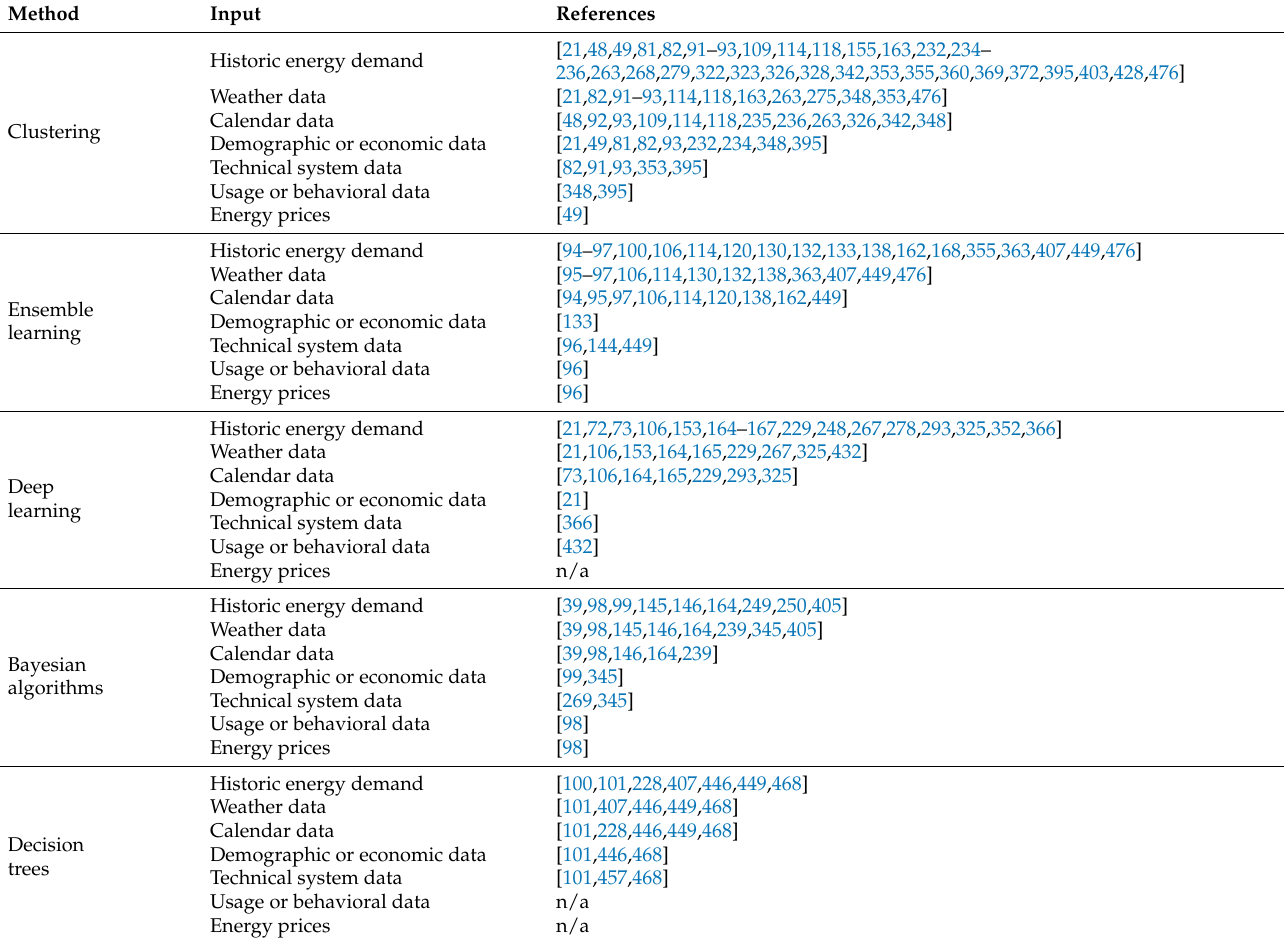
Table A5. Techniques and input data used per article (2/4). Continuation of Table